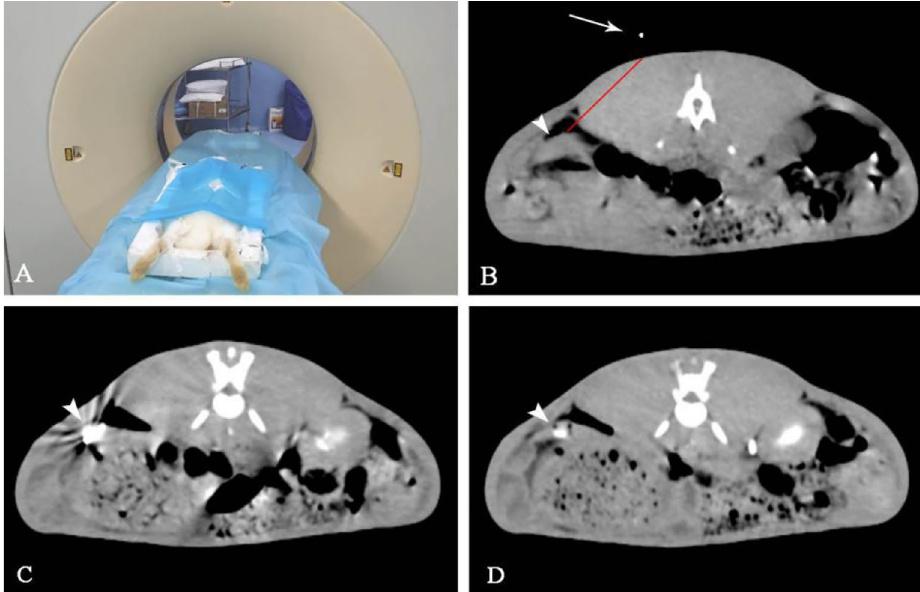
Figure 2. CT-guided percutaneous splenic implantation. The rabbits were fixed on the CT scanning table in a prone position ( A ); A self-made metal positioner (arrow) was used for positioning, the puncture path was determined (red line) ( B ), spleen (arrowhead); a 22G coaxial puncture needle (arrowhead) was used to puncture the rabbit spleen ( C ); The needle path was blocked with a gelatin sponge (arrowhead) ( D